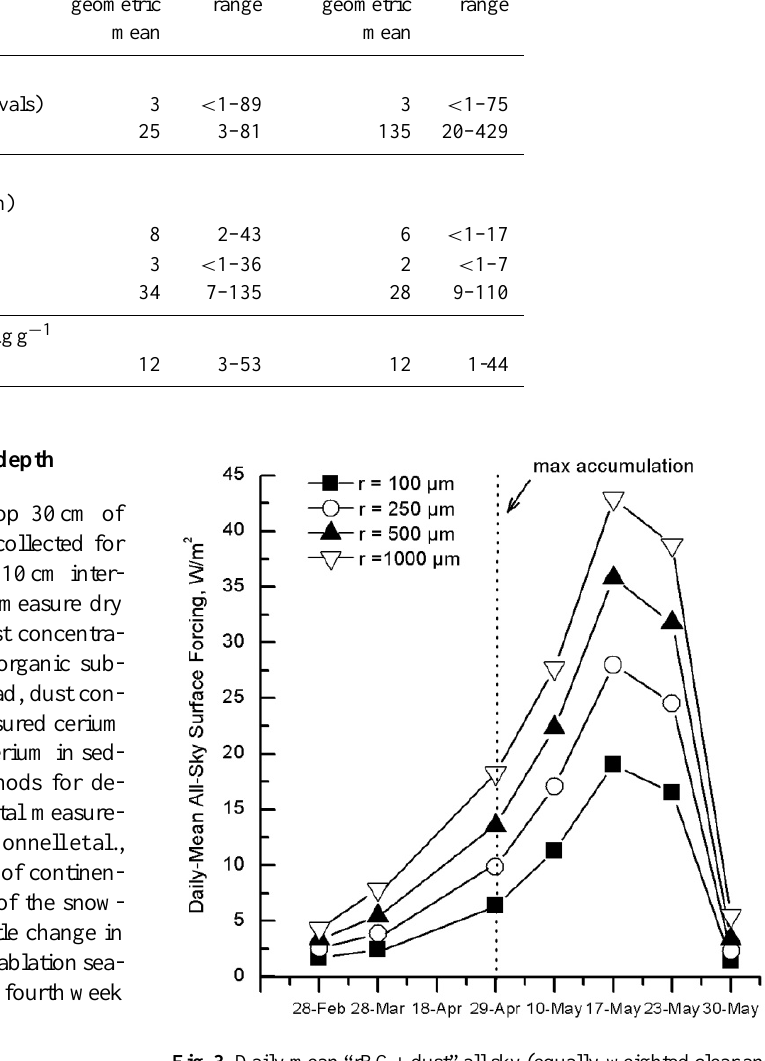
Fig. 3. Daily mean “rBC+dust” all sky (equally-weighted clear and cloudy conditions) surface radiative forcing with different snow effective radii based on the vertical distribution of rBC concentrations in entire snowpack profiles measured in 2009 at Mammoth Mountain, and continental dust measured in the top 30 cm of snowpack.